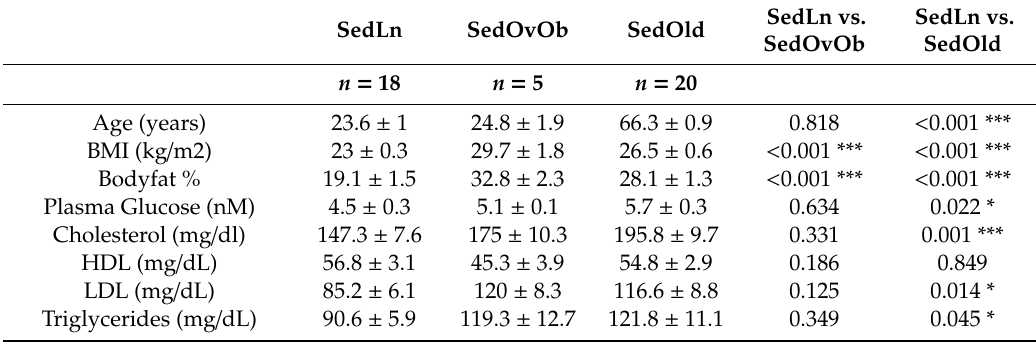
Table 1. Anthropometric measures and blood metabolic markers. Bodyfat acquired through dual energy X-ray absorptiometry (DEXA) analysis. Blood metabolic markers were obtained from plasma isolated from participants after eight hours of fasting immediately prior to satellite cell isolations. SedLn vs. SedLn vs. SedLn SedOvOb SedOld SedOvOb SedOld n = 18 n = 5 n = 20 Age (years) 23.6 ± 1 24.8 ± 1.9 66.3 ± 0.9 0.818 < 0.001 *** BMI (kg / m2) 23 ±